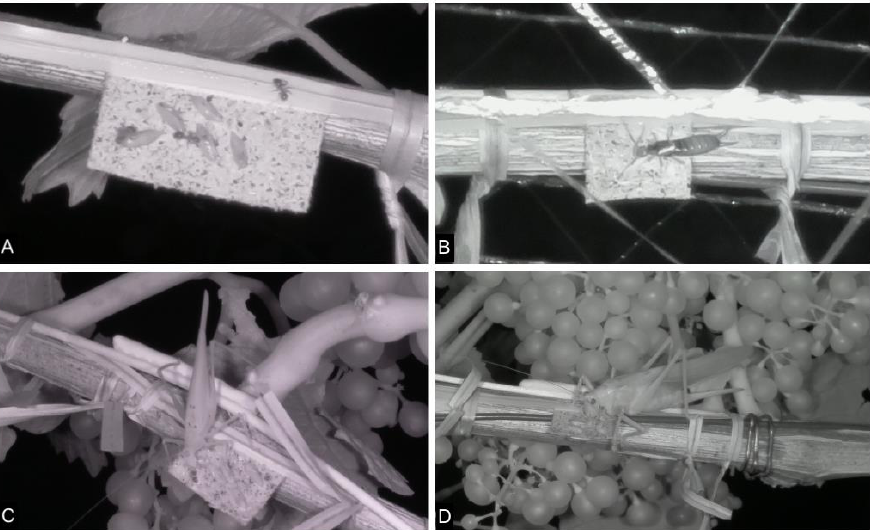
Figure 4. Predators photographed on sentinel cards. Selected pictures of ( A ) Formicidae, ( B ) Forficula auricularia , ( C ) Phaneroptera nana (male), and ( D ) Tettigonia viridissima (female). Counterintuitively, organic farming did not enhance natural pest control, but actu-